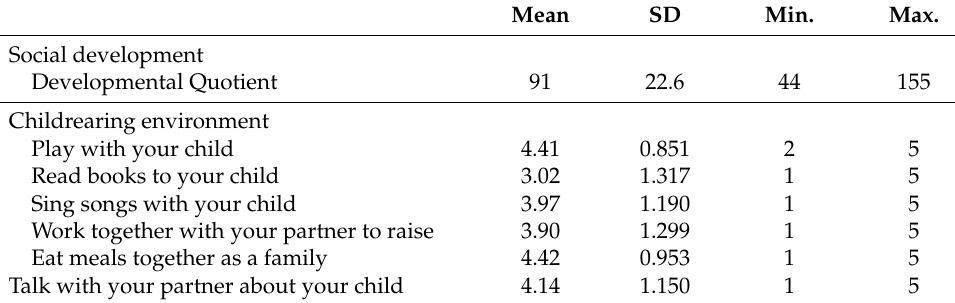
Table 1. Simple results of the questionnaire survey.